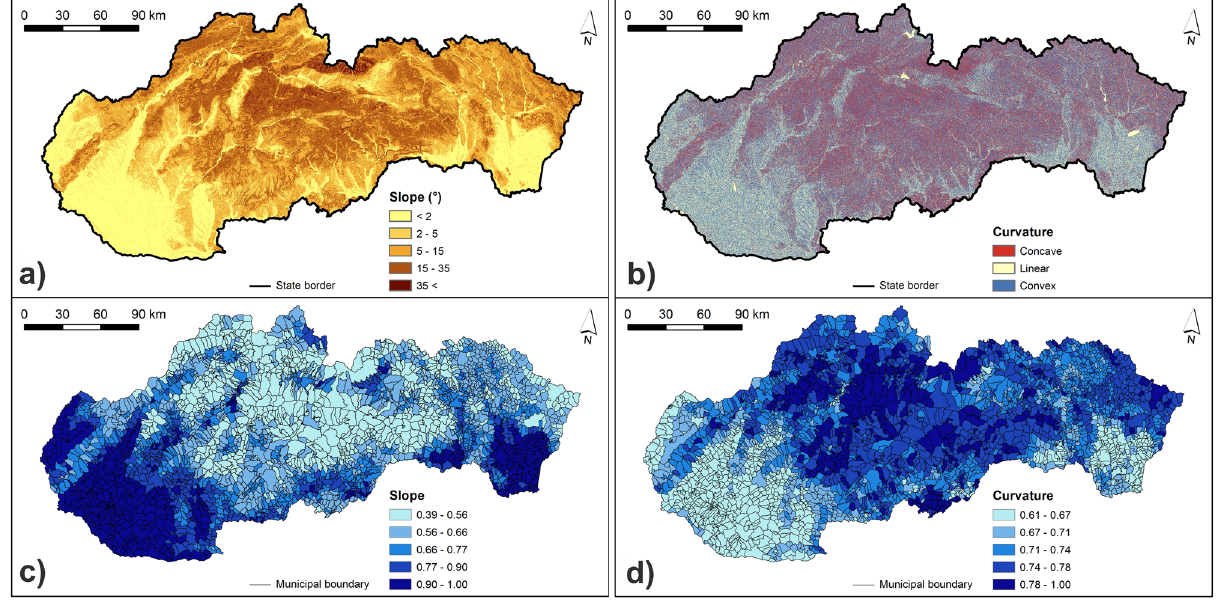
Figure 4. Slope and curvature indicators: ( a ) original slope values; ( b ) original curvature values; ( c ) normalized slope values; ( d ) normalized curvature values. This figure was generated in ArcGIS 10.2.2 software.